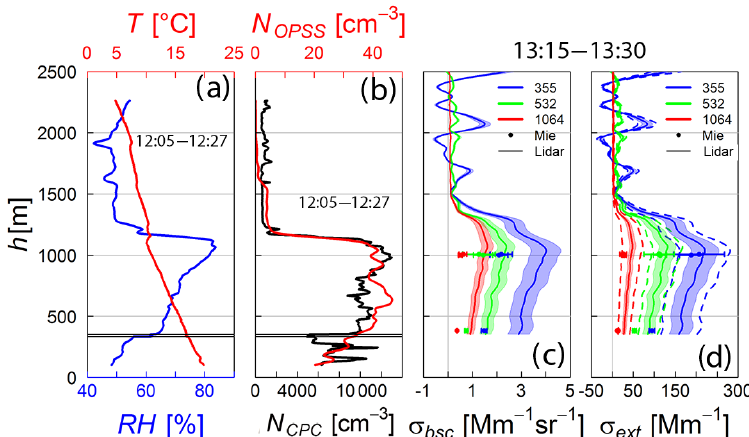
Figure 13. Panel (a) shows the profiles of the ambient relative humidity (RH, blue) and temperature ( T , red), whereas panel (b) illustrates the PNC derived with the CPC on ACTOS ( N CPC , black) and the PNC derived with the OPSS ( N OPSS , red). The black thin horizontal lines in panels (a) and (b) mark the height where the profile was composed out of several vertical parts of flight 14b. The profile was flown between 12:05 and 12:27UTC in the beginning of the flight. Panels (c) and (d) display the lidar-based particle light backscatter coefficient ( σ bsc, lid (λ) ) and the particle light extinction coefficient ( σ ext, lid (λ) ) for three wavelengths (355 (blue), 532 (green), and 1064nm (red)) averaged over the period 13:15–13:30UTC of 14 September. σ bsc, lid (λ) and σ ext, lid (λ) were smoothed (algorithm uses every sixth data point) within 350 and 2500m height. Also, the results of the airborne-based particle light backscatter ( σ bsc, mie (λ) ) and extinction coefficient ( σ ext, mie (λ) ) are shown as colored dots for three different wavelengths (coloring same as for the lidar-based values). The error bars of the dots indicate the 3 times the standard deviation of the mean value over 50 runs of the Mie algorithm calculations. The shaded area around the lidar profiles marks the 15% error. The solid lines in the extinction panel (d) represent the profile for the extinction calculated out of the backscattering using the LR presented here (55sr for 355 and 532nm, 30sr for 1064nm). The dashed line signs the extinction profile using a LR ±